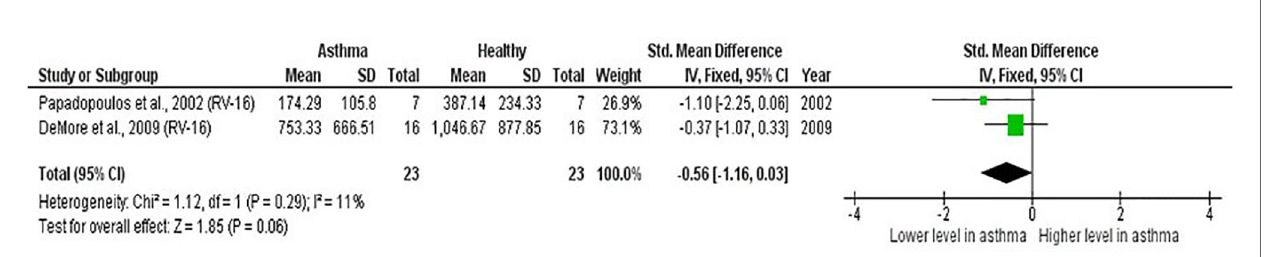
FIGURE 4 | Forest plot of IFN- g for ex vivo PBMCs studies comparing adults with atopic asthma vs non-atopic healthy controls. PBMCs from adults with atopic asthma produced lower levels of IFN- g (ES: -0.56) compared with healthy adults after RV infection, and it was close to reaching statistical signi fi cance ( p